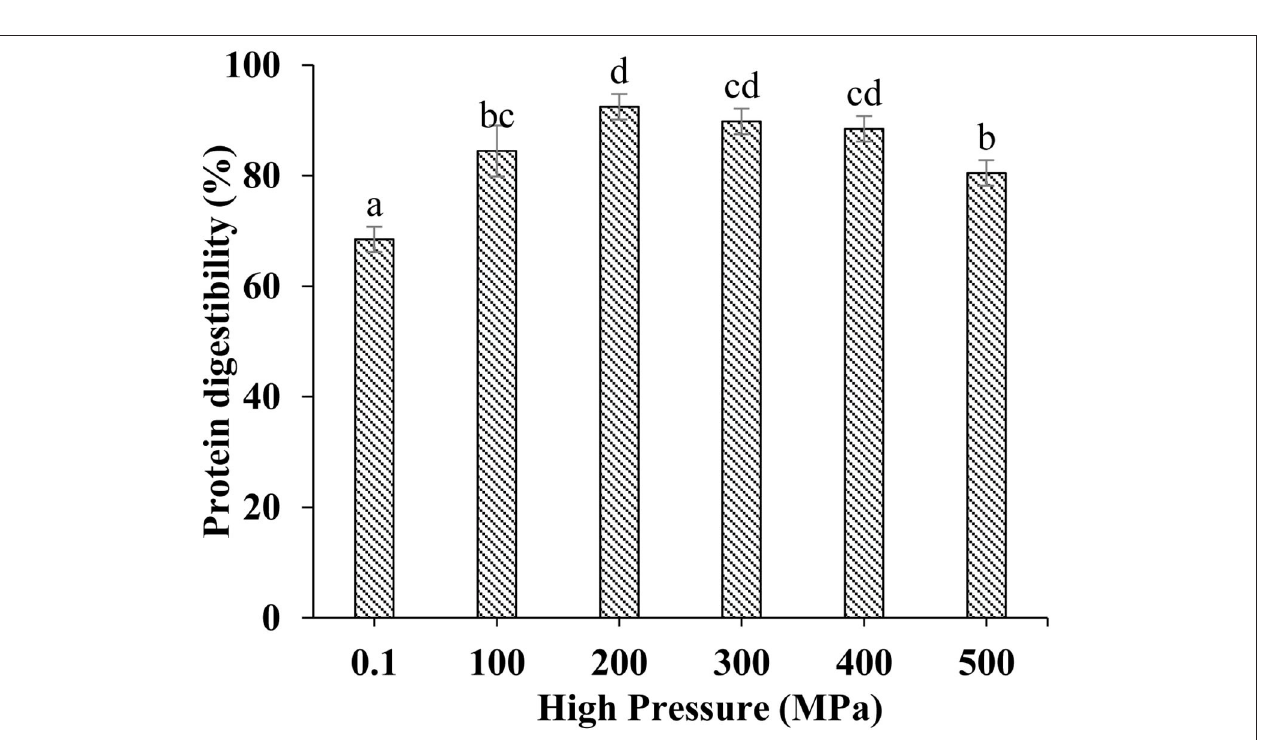
FIGURE 6 | In vitro digestibility of MP from the scallop mantle treated by the UHP